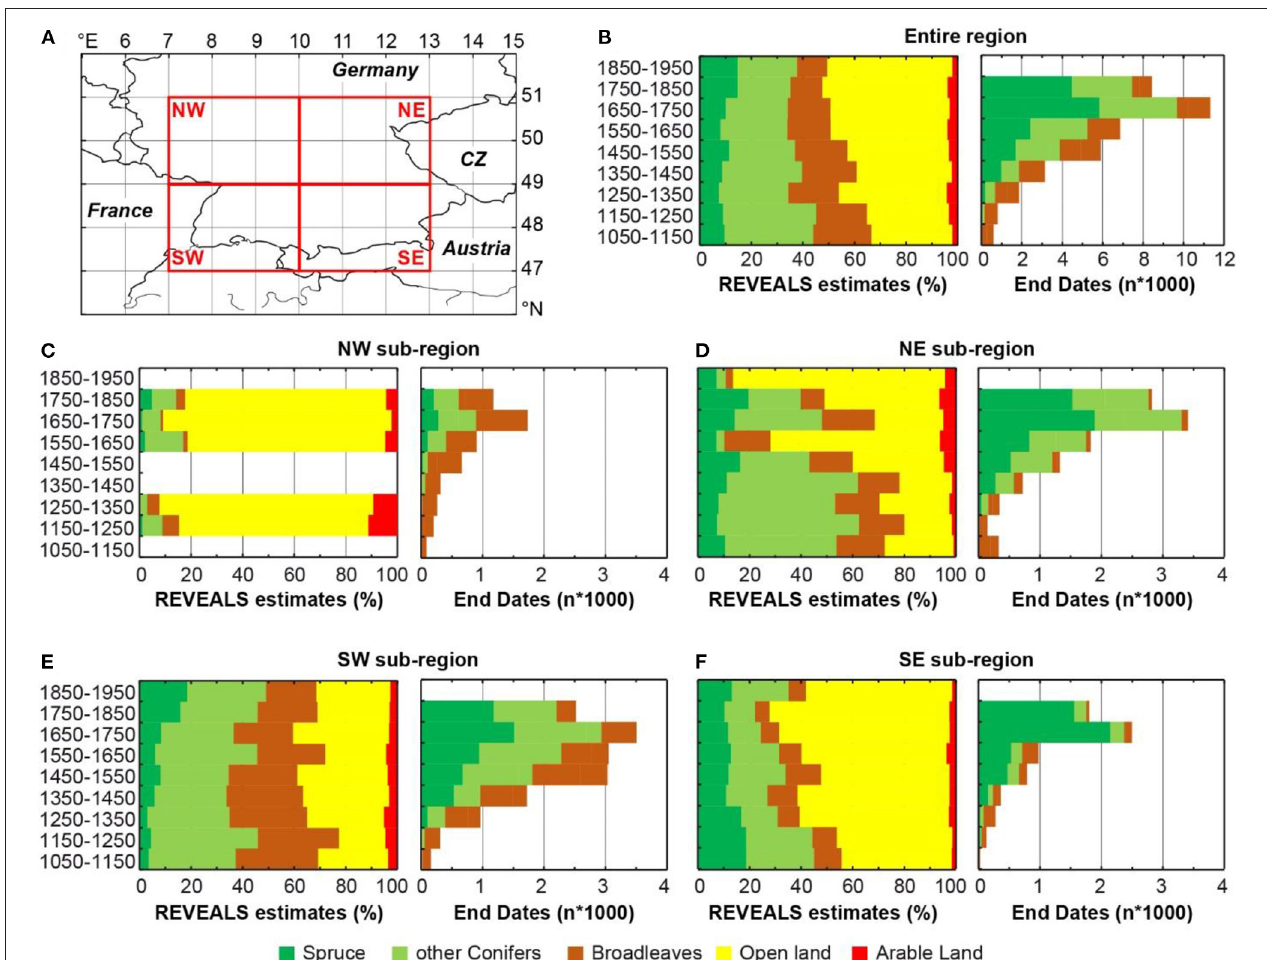
FIGURE 3 | (A) Study area and its four sub-regions [northwest (NW), northeast (NE), southwest (SW) and southeast (SE)] for which (B–F) REVEALS estimates for spruce ( left panels ) are compared to the number of end dates from dendrochronologically dated spruce timber ( right panels ). REVEALS estimates for other coniferous and broadleaved plant covers, open land and arable land are also